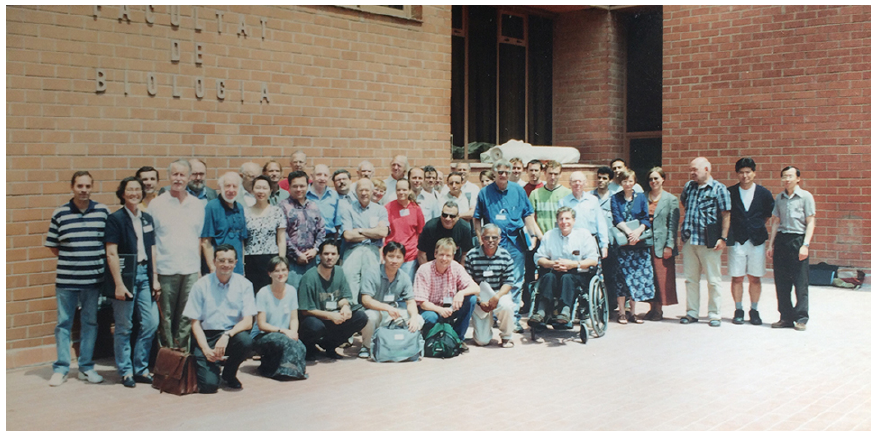
Figure 3: The participants of the conference Distributions with given marginals and statistical modelling , held in Barcelona in 2000 (see the proceedings in [5]). Roger Nelsen is standing, fourth from the left.